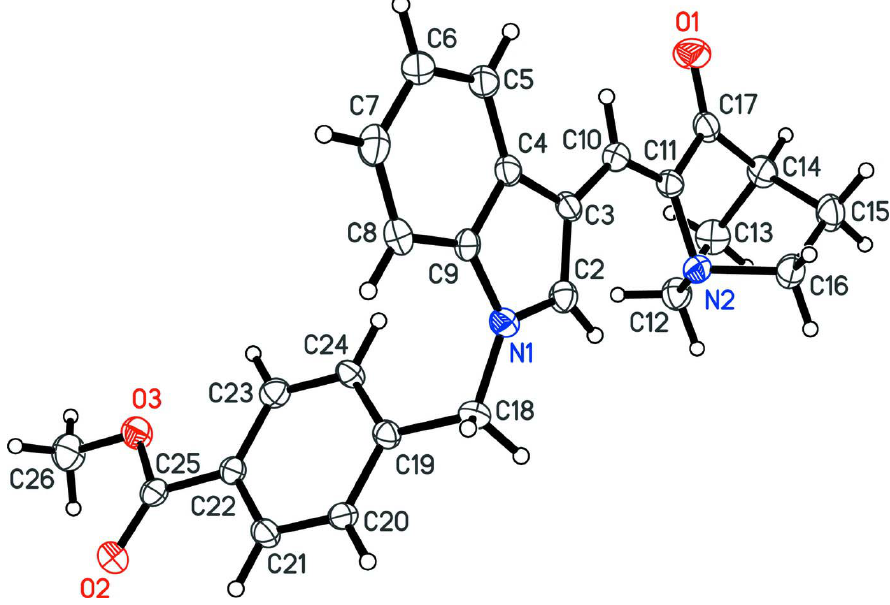
A view of the molecule with the atom numbering scheme. Displacement ellipsoids are drawn at the 50% probability